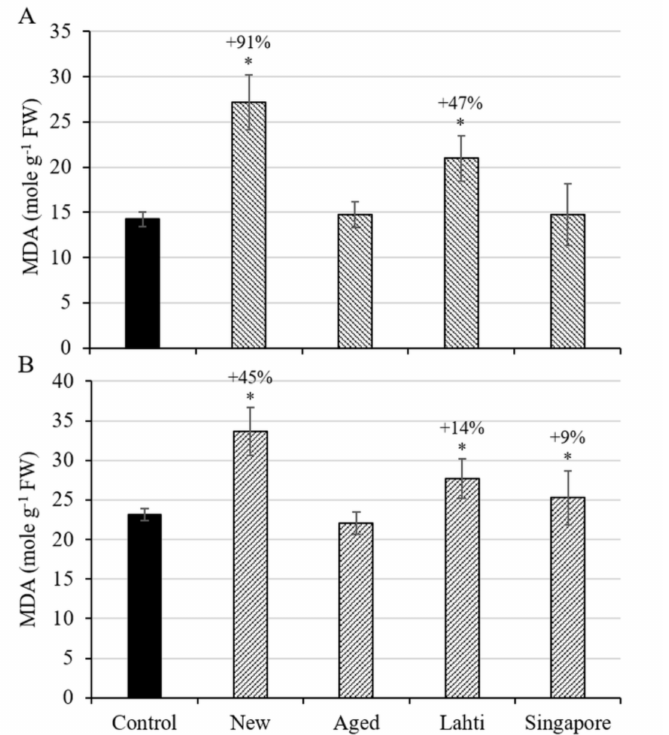
Figure 3. Lipid peroxidation expressed by the concentration of malondialdehyde (MDA) in roots ( A ) and shoots ( B ) of T. aestivum seedlings exposed to ≤ 4 mm microplastic particles from threaded bottle caps (new, artificially aged caps collected in Lahti and Singapore) in the soil for seven days compared to controls without microplastic in soil. Data represent mean MDA ± standard deviation. Significance compared to the control is represented by an asterisk (*) where p < 0.05 ( n = 400).